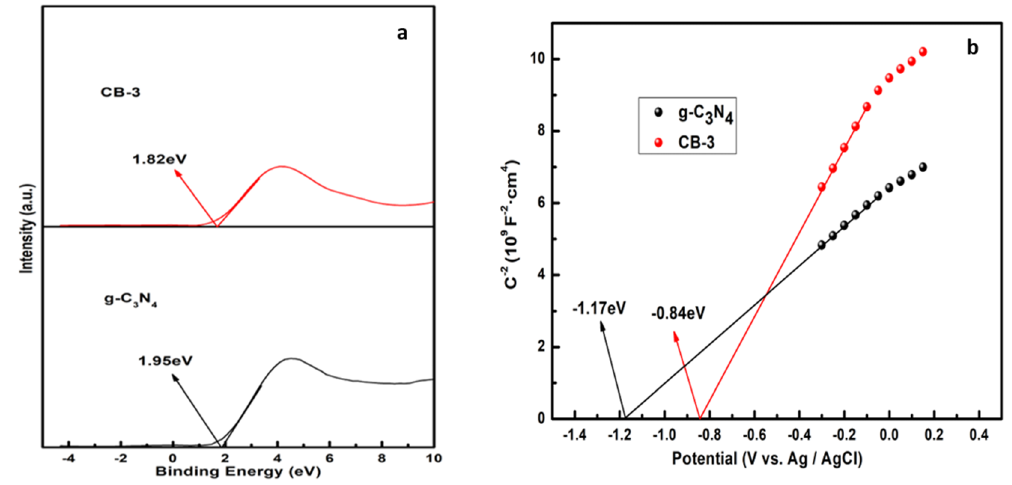
Figure 10. ( a ) VB-XPS, ( b ) Mott-Schottky plots.